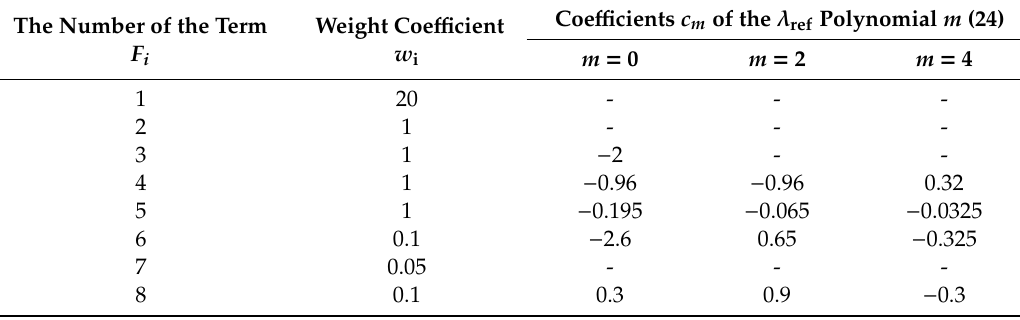
Table 1. Fitness function coe ffi cients applied for gain selection of the proportional observer. The Number of the